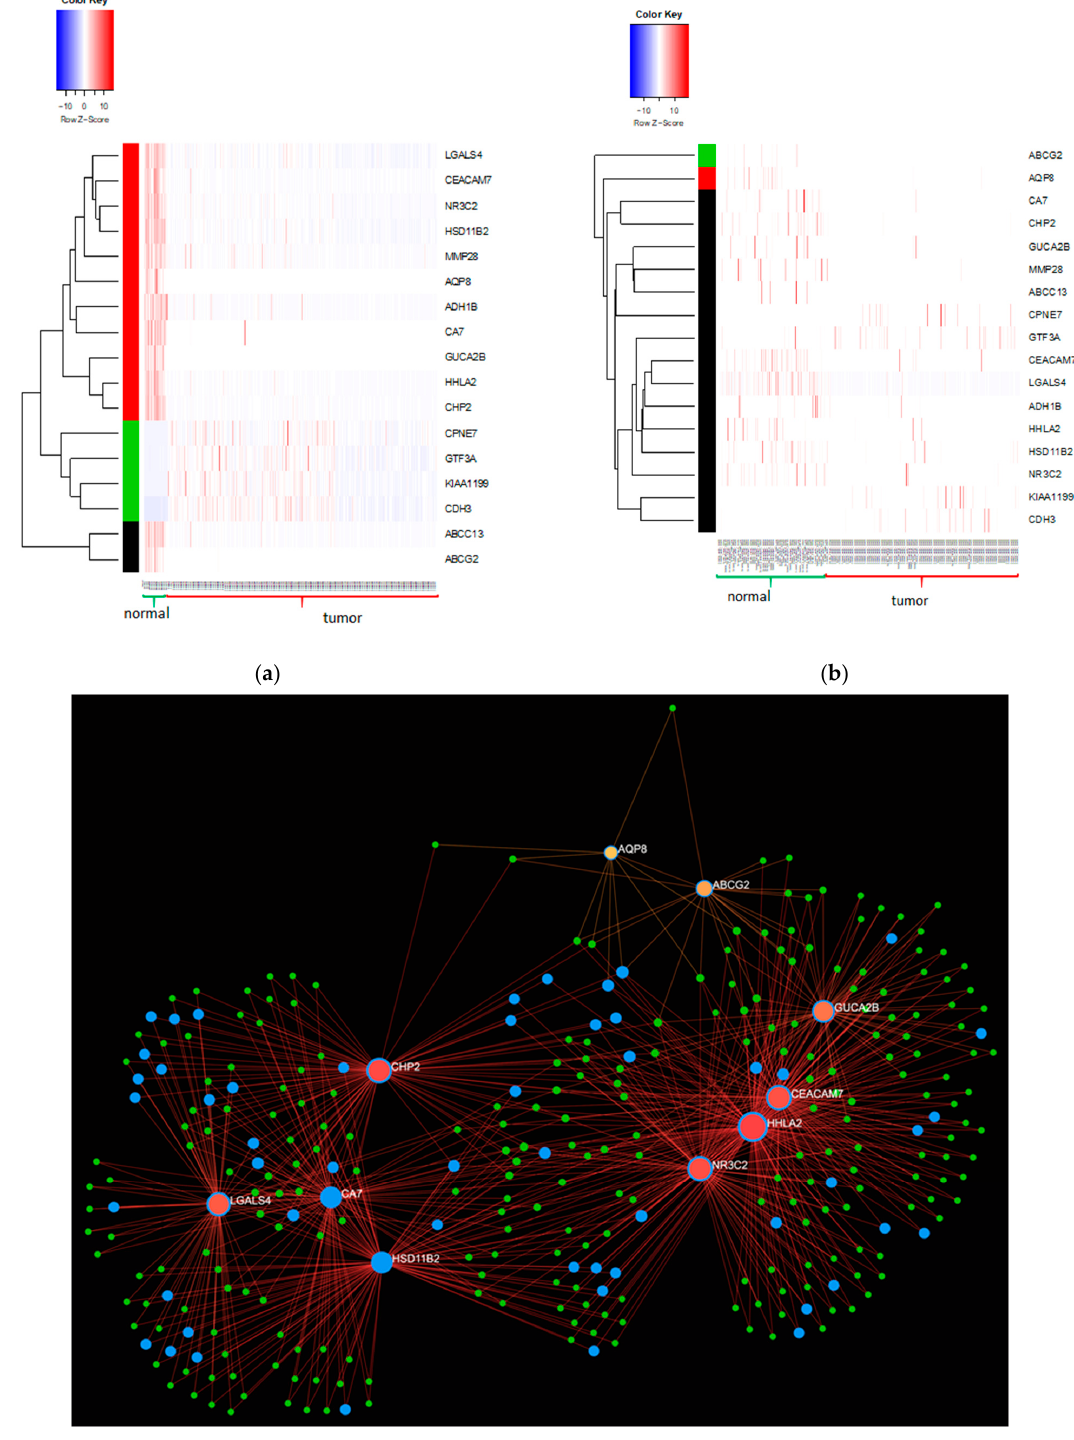
Figure 5. ( a ) Shows the heatmaps for the 17 genes in the bulk RNA sequencing dataset; ( b ) heatmap for the 17 genes (single cell RNA sequencing). Red denotes upregulation, white indicates no expression or zero expression and blue depicts low expression; both heatmaps were performed using hierarchical clustering on the rows. The three clusters are coloured as red, black and green; ( c ) the network was generated using the 17 genes that were found to be differentially expressed in the network. The seed genes are labelled and shown in red, while the proteins connected to these genes are shown in green. The interactions between the genes and the proteins are shown in red. The blue coloured proteins or seed genes are involved in the metabolic pathways from